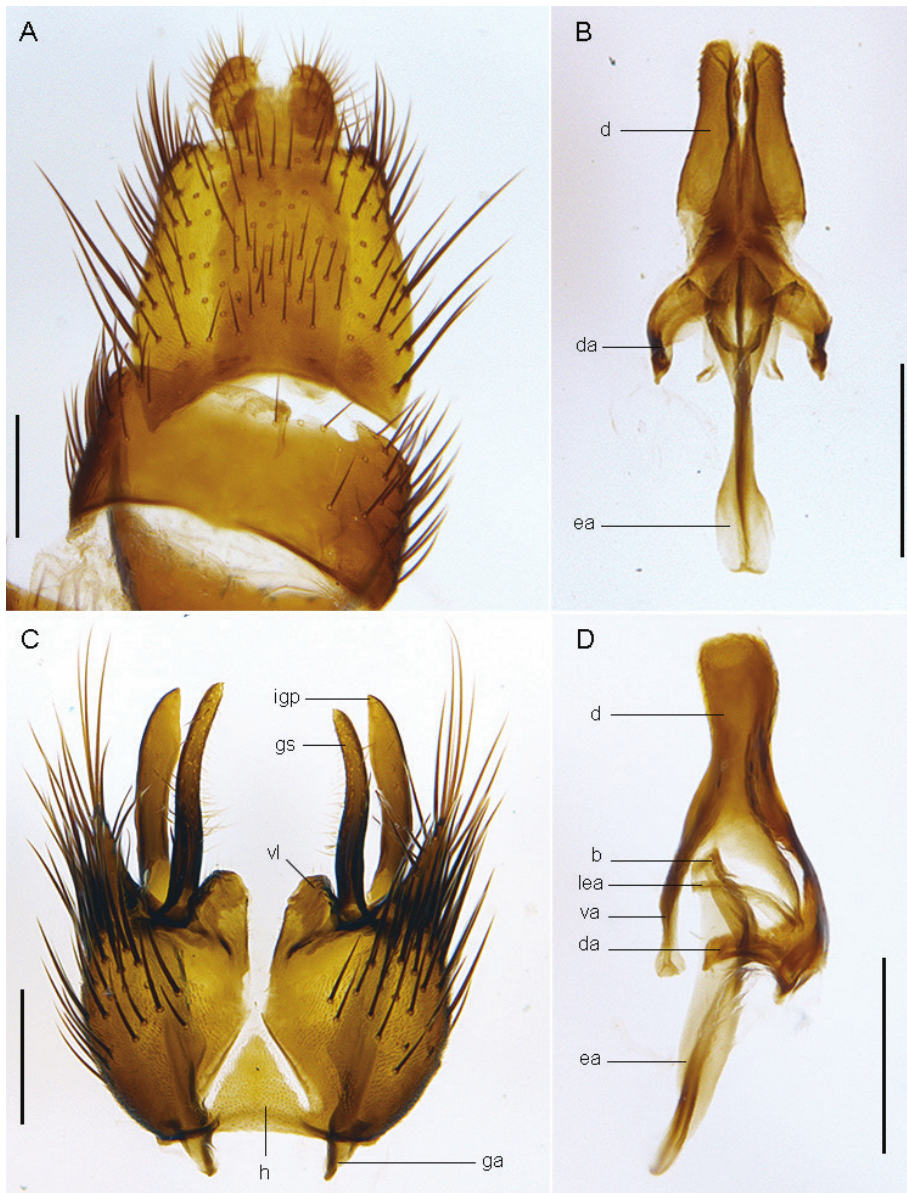
Figure 19. Sidarena yallingup sp. n.: Male genitalia: A Epandrium and tergite 8, dorsal view B Aedeagus, dorsal view C Gonocoxites, ventral view (epandrium and aedeagus removed) D Aedeagus, lateral view. Scale line: 0.2 mm. Abbreviations: b , basiphallus; d , distiphallus; da , dorsal apodeme of parameral sheath; ea , ejaculatory apodeme; ga , gonocoxal apodeme; gs , gonostylus; h , hypandrium; igp , inner gonocoxal process; lea , lateral ejaculatory apodeme; va , ventral apodeme of parameral sheath; vl , ventral lobe. Scale line = 0.2